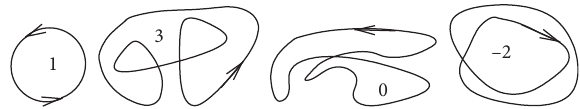
Figure 1: Examples of curves of different rotation